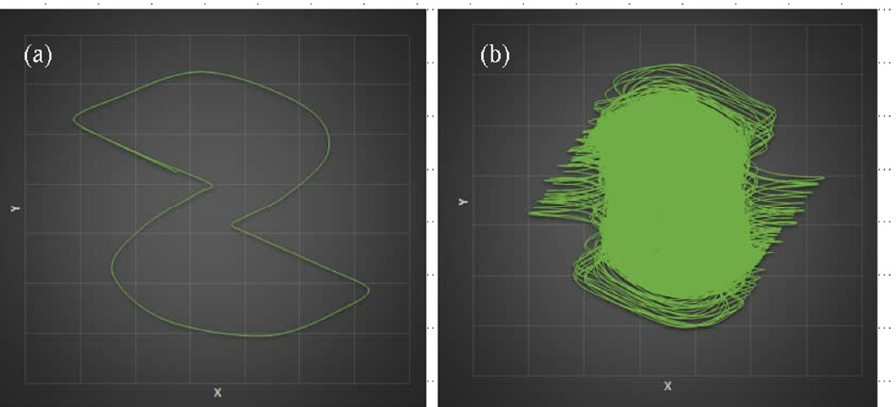
Figure 6. Experimental coexisting phase portraits obtained from the microcontroller implementation of the Tabu learning neuron. ( a ) and ( b ) are phase portraits of periodic and chaotic attractors, respectively, obtained with the same set of parameters given in Figure 4.